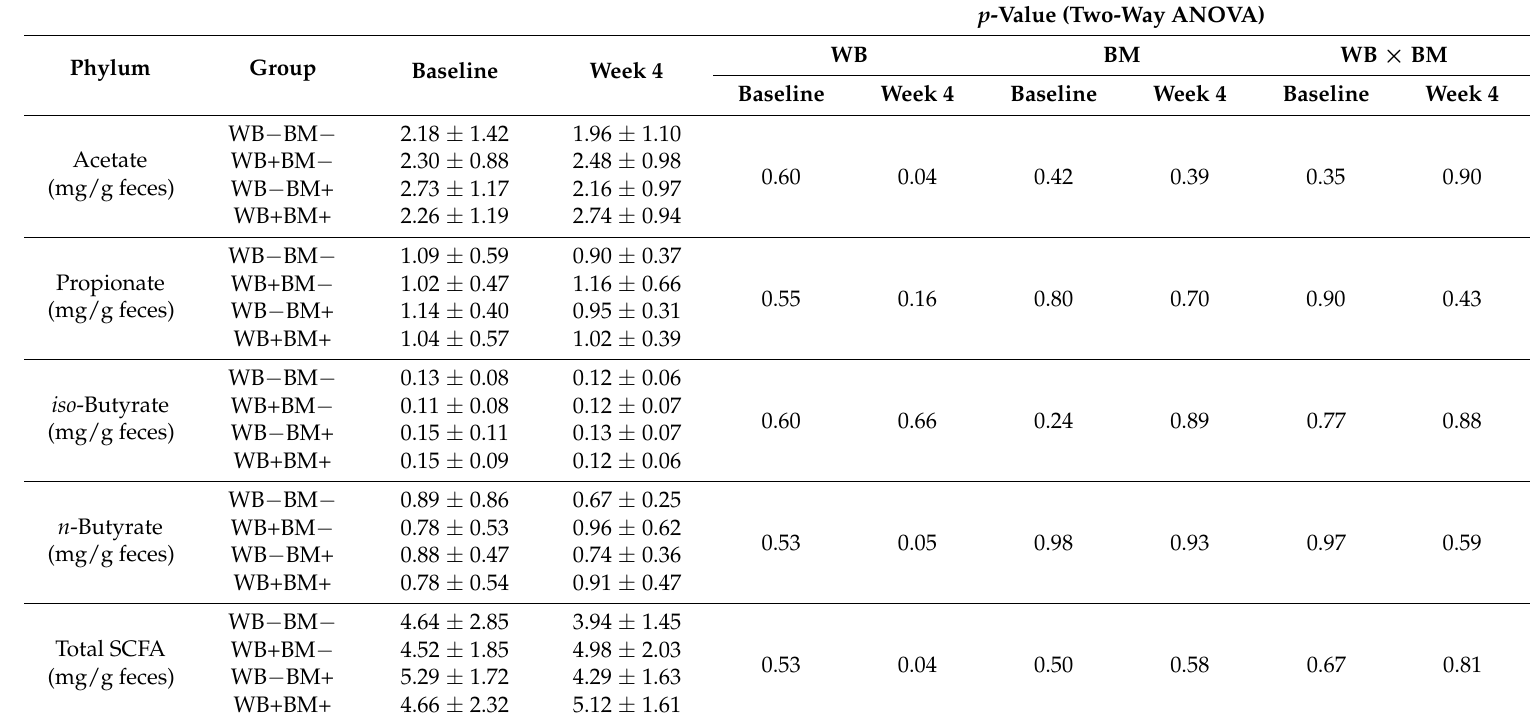
p -Value (Two-Way